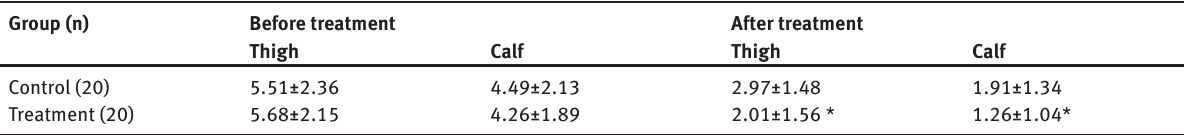
Table 2: Differences in the thigh and calf circumferences between the affected and non-affected limbs in the patient groups before and after treatment Group (n)